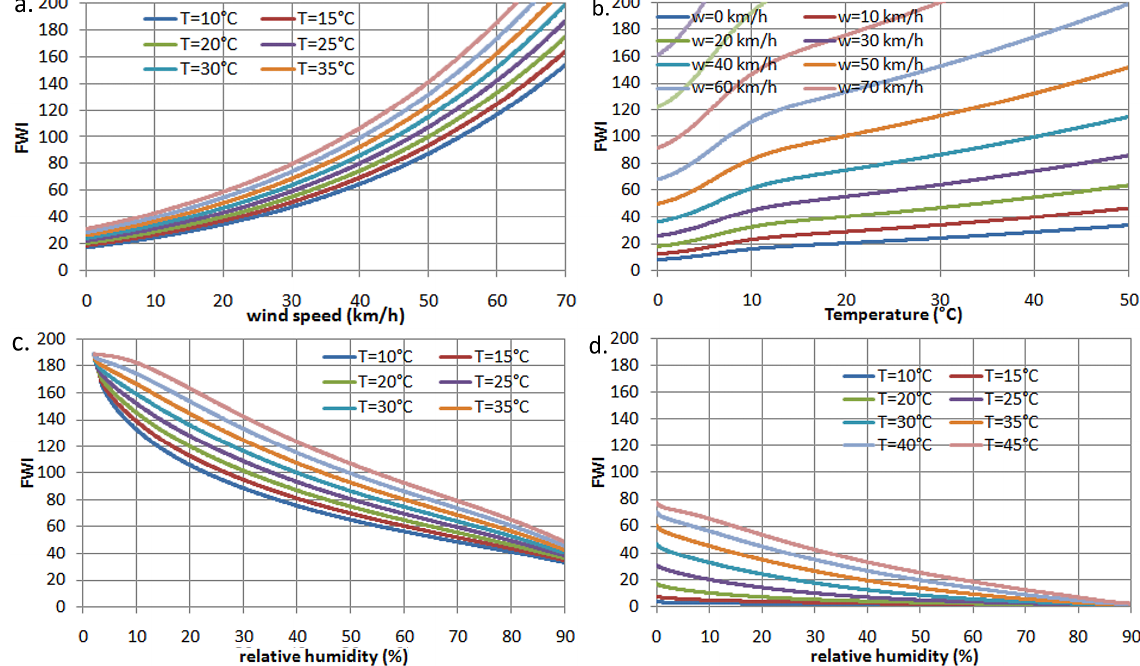
Fig. 3. Families of curves of FWI as a function of the meteorological parameters: (a) FWI as a function of wind speed (in kmh − 1 ) for different temperatures and for rh=50% and zero precipitation, (b) FWI as a function of temperature (in ◦ C) for different values of wind speed and for T =35 ◦ C and zero precipitation, (c) FWI as a function of relative humidity (%) for different temperatures and for w =40kmh − 1 and zero precipitation, and (d) FWI as a function of relative humidity (%) for different temperatures and for w =40kmh − 1 and 10mm precipitation.